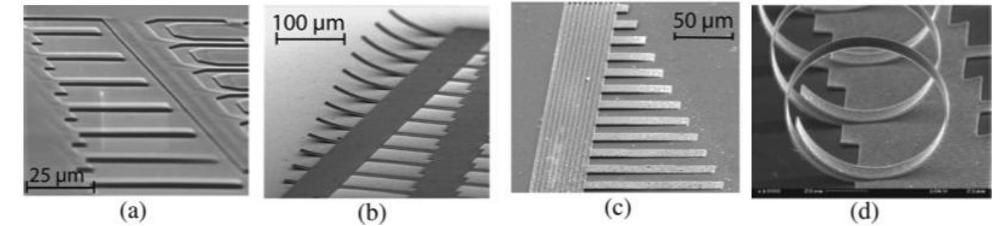
Figure 11. 3D structures for frequency analog gas-flow sensing